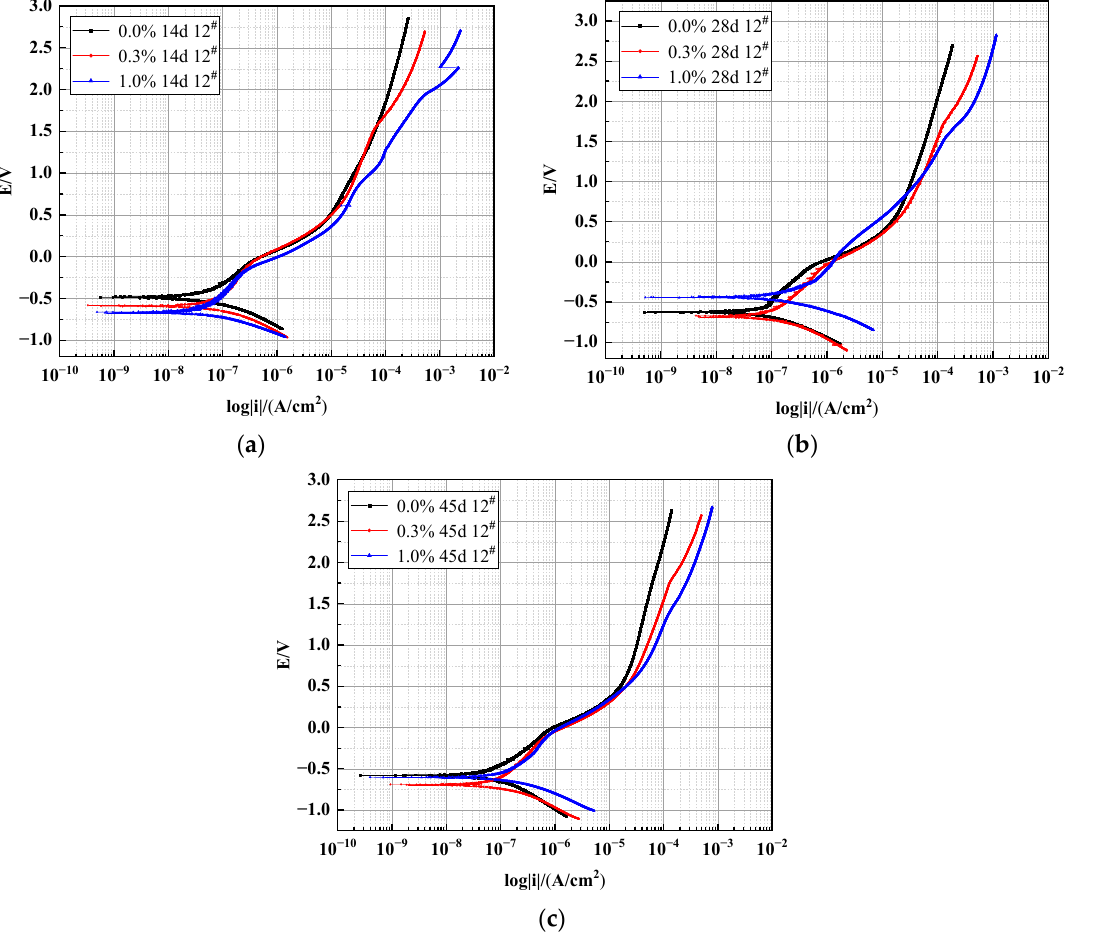
Figure 7. Variation of soil column conductivity with time for different NaCl contents: ( a ) 0%, ( b ) 0.3%, ( c ) 1.0% NaCl.